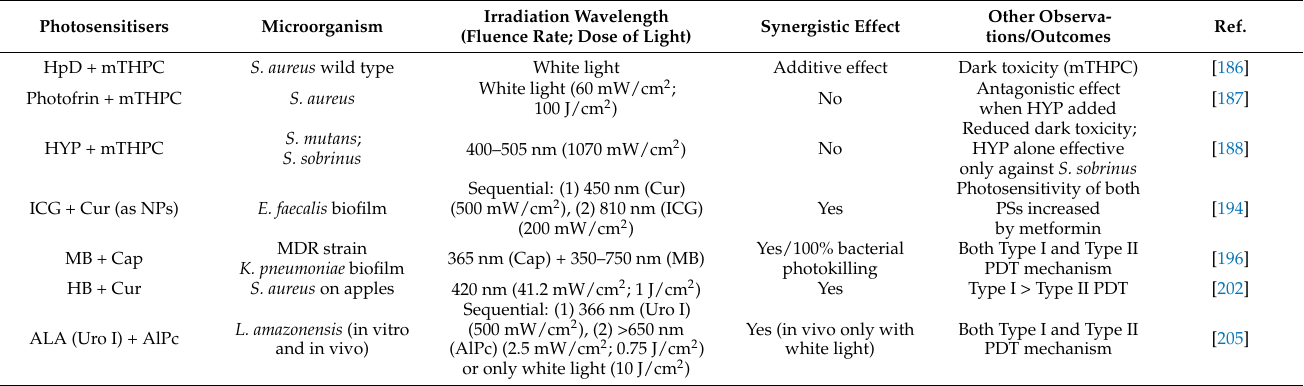
Table 2 summarises the combinations of two PSs in antimicrobial PDT. Table 2. Summary of the combinations of two PSs in PACT/PDI with representative